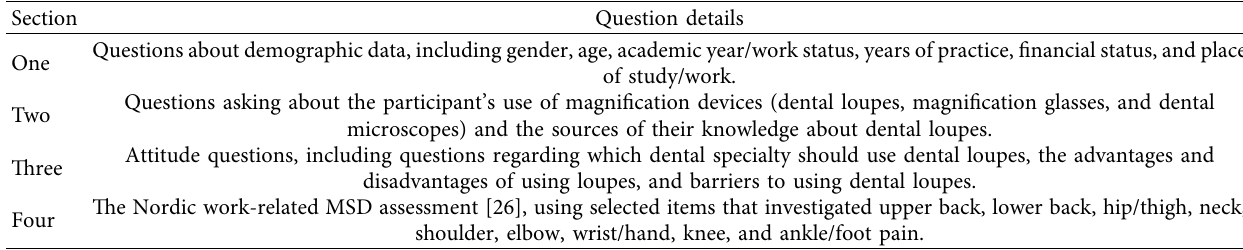
Table 1: The study questionnaire. Section Question details